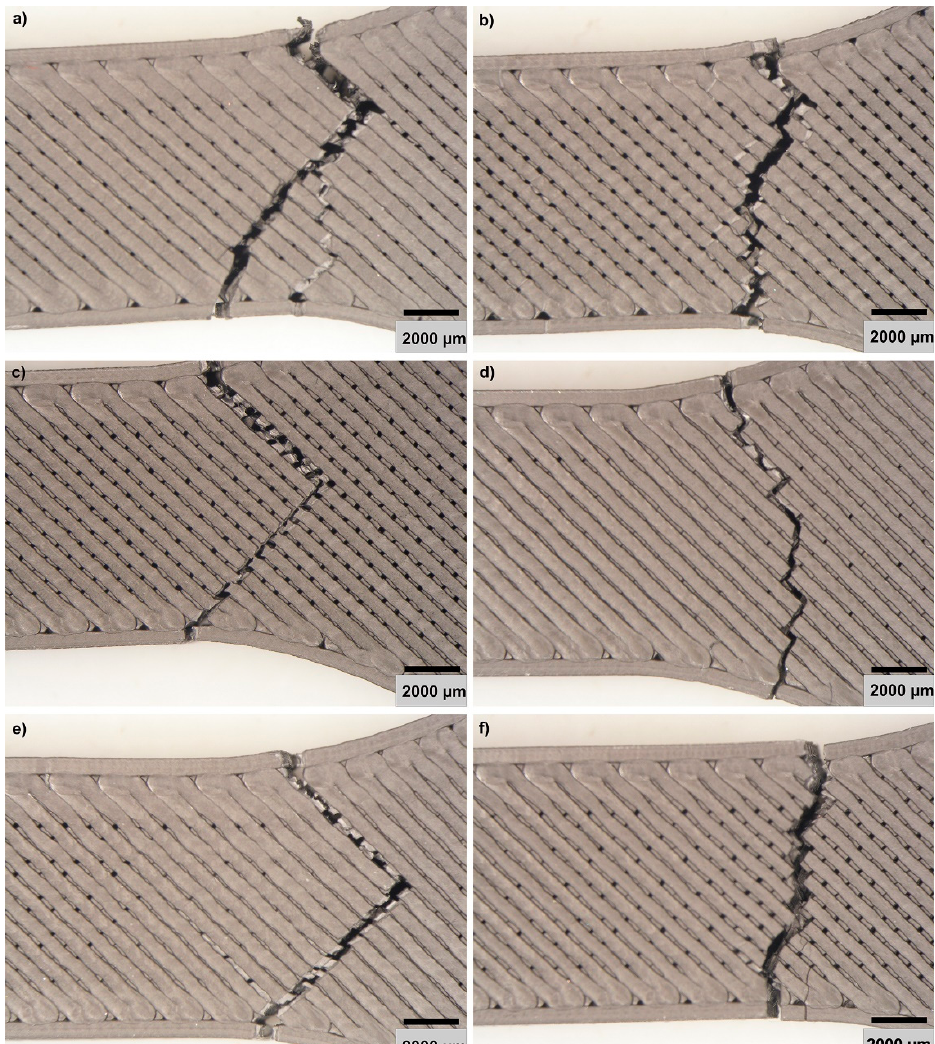
Figure 7. Macrostructural aspects at stereomicroscope of polylactic acid material with graphene particles in longitudinal cross section, with different 3D printing parameters: ( a ) 60% interior fill percentage and 45 ° thread deposition;( b ) 60% interior fill percentage and 60 ° thread deposition; ( c ) 80% interior fill percentage and 45 ° thread deposition;( d ) 80% interior fill percentage and 60 ° thread deposition; ( e ) 100% interior fill percentage and 45 ° thread deposition; ( f ) 100% interior fill percentage and 60 ° thread deposition.